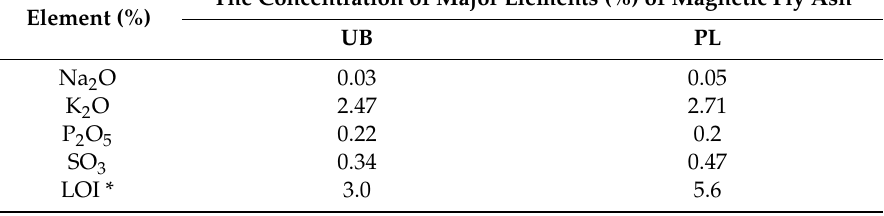
Note *: Loss on ignition